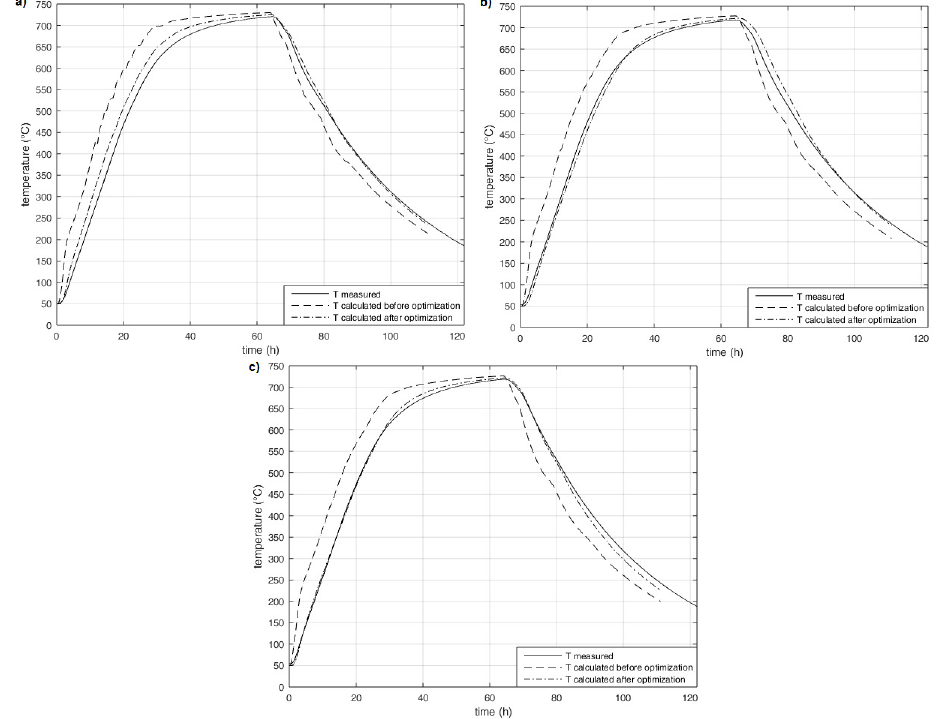
Figure 15. Comparison of directly measured temperature (T measured) to indirectly measured temperature before (T calculated before optimization) and after (T calculated after optimization) optimization for temperature ( a ) T 6 , ( b ) T 7 , and ( c ) T 8 for operating measurement 3, coil